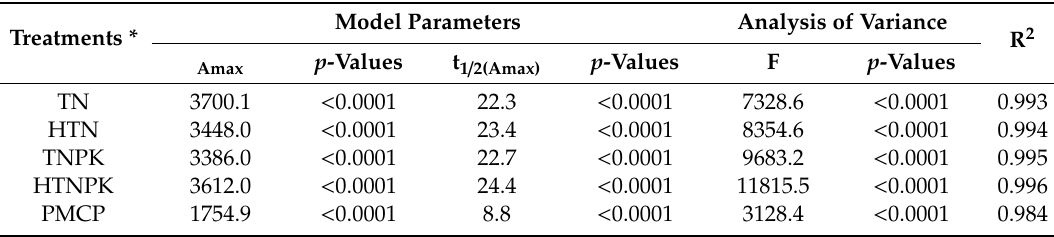
Table 7. Estimation model for SiO 2 release from di ff erent types of the blended biochar pellet. Model Parameters Treatments *